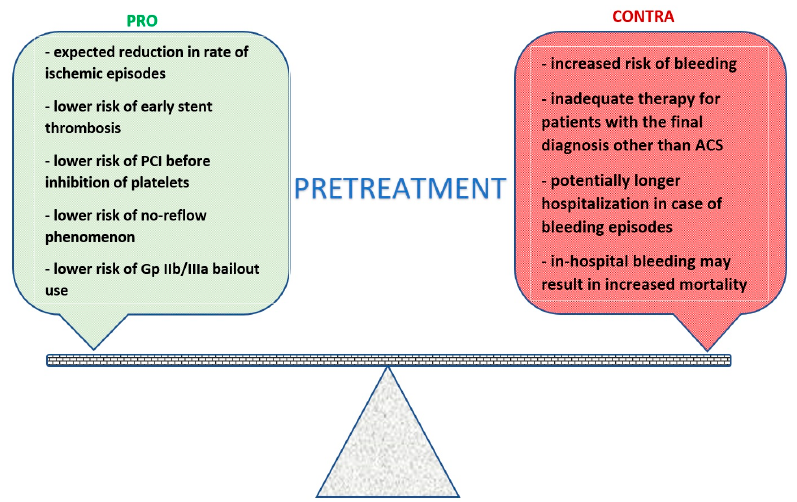
Figure 1. Commonly raised arguments for and against pretreatment in ACS patients. PCI—percutaneous coronary intervention, Gp—glycoprotein, ACS—acute coronary syndrome.